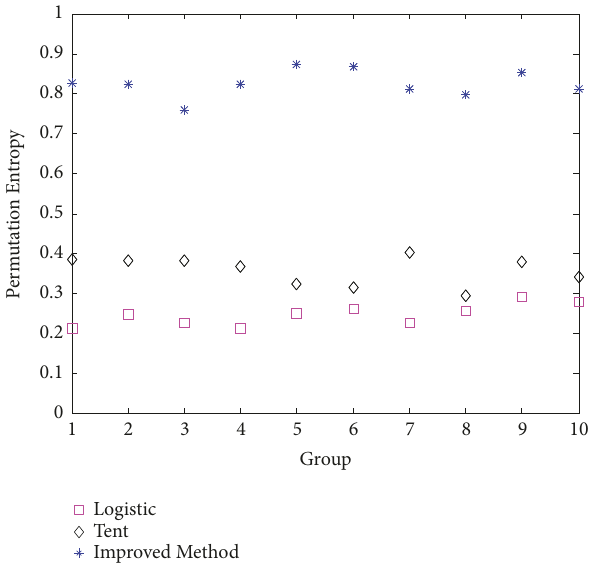
Figure 7: PE analysis with three different chaotic